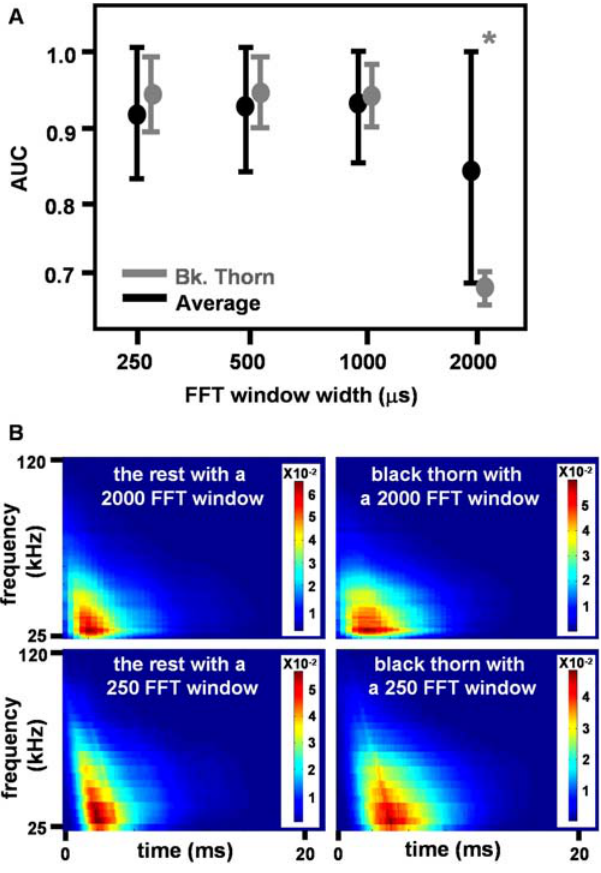
Figure 6. Effect of the DFT window length on classification performance. (A) The area under the ROC curve (AUC) for four different window lengths ranging from 250–2000 m s. Average results are presented together with the blackthorn classification case, in which the effect was most clear. The difference between a 2000 m s window length and the other lengths is significant (P , 0.05), whereas the difference between the three other lengths is not. (B) Average spectrograms for a window length of 2000 m s (first row) and a 250 m s one (second row) for the classification task of blackthorn vs. the rest. It can be seen how time information is decreased (i.e. smeared) for the 2000 m s window (first row). This makes separation between the two classes easier with the 250 m s window (second row) even when only examining them visually.